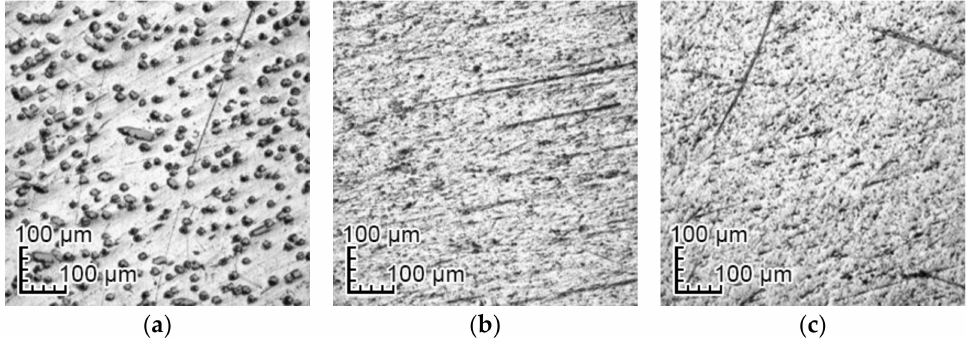
Figure 1. Examples of surface condition after polishing: ( a ) PEEK GRF30 (reinforced with 30% glass fiber), ( b ) Ti6Al4V SLM (selective laser melting), and ( c ) Ti6Al4V.